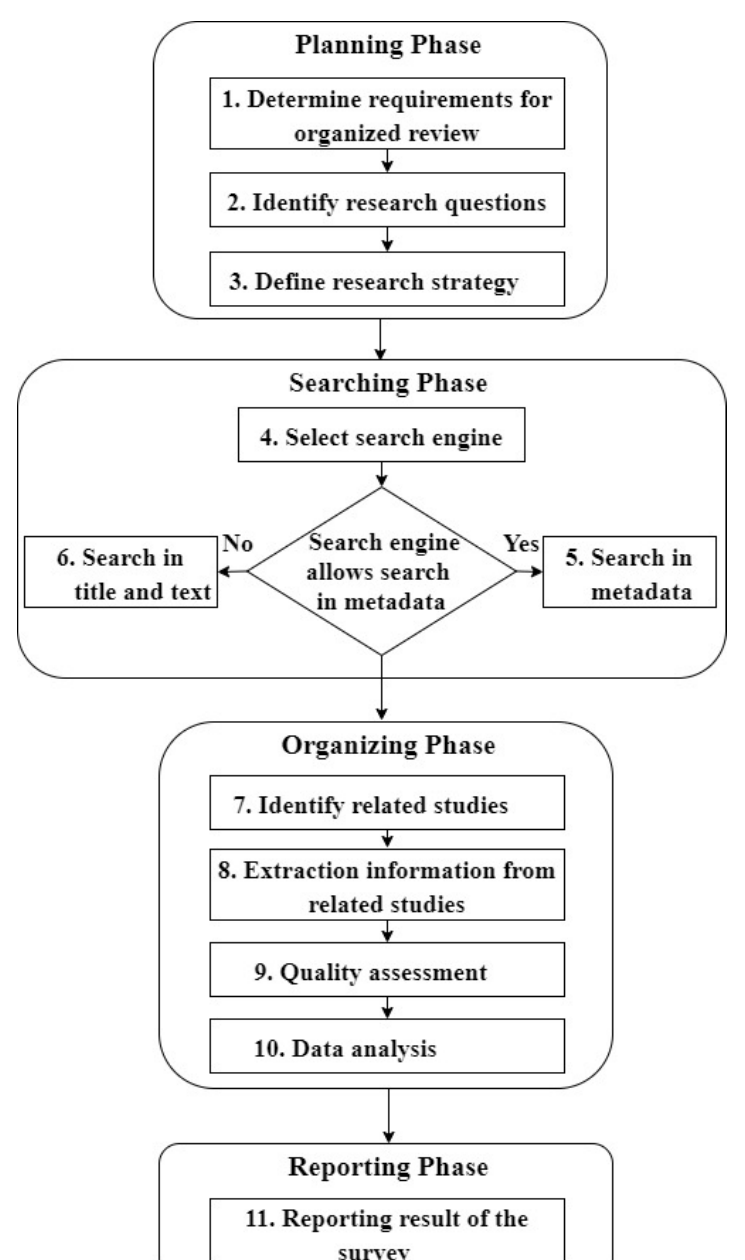
Figure 4. Systematic literature review